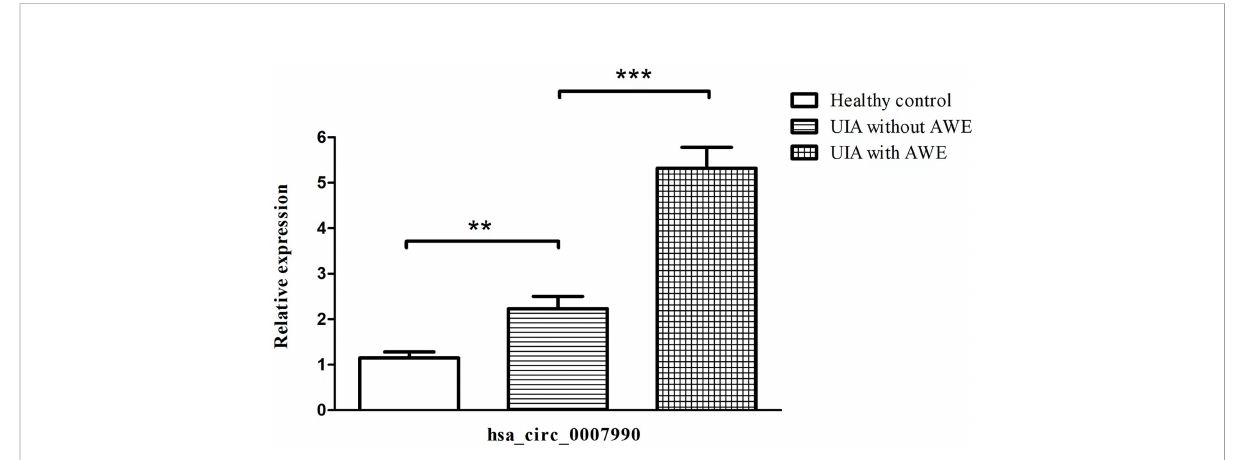
FIGURE 2 Upregulated expression of hsa_circ_0007990 associated with aneurysm wall enhancement con fi rmed by RT-PCR. The data are the mean ± SD, **p < 0.01, ***p <